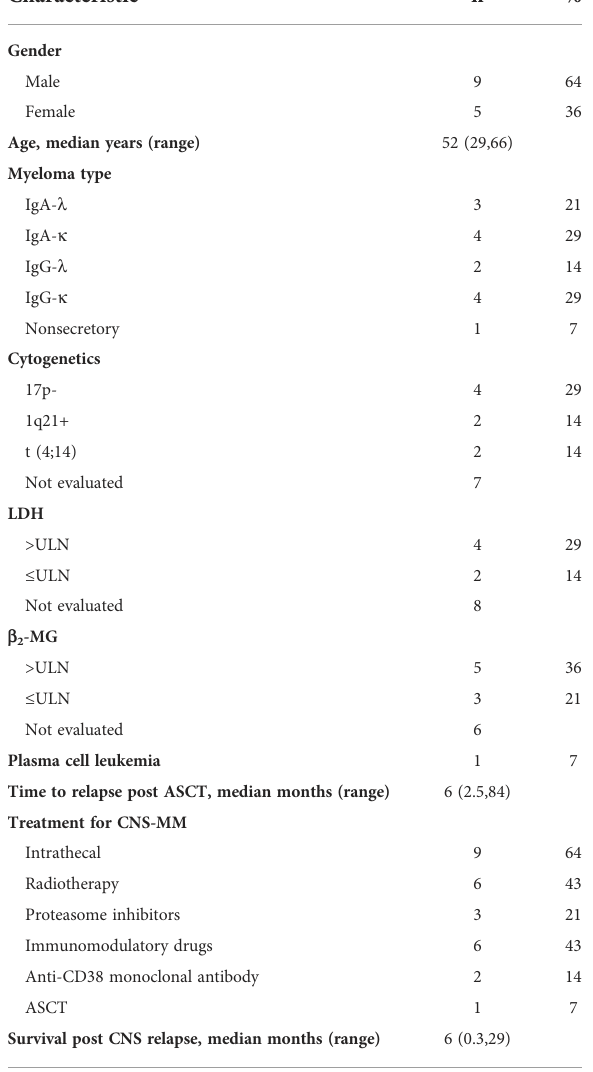
TABLE 2 Summary of multiple myeloma cases who had isolated CNS relapse after ASCT (n=14).